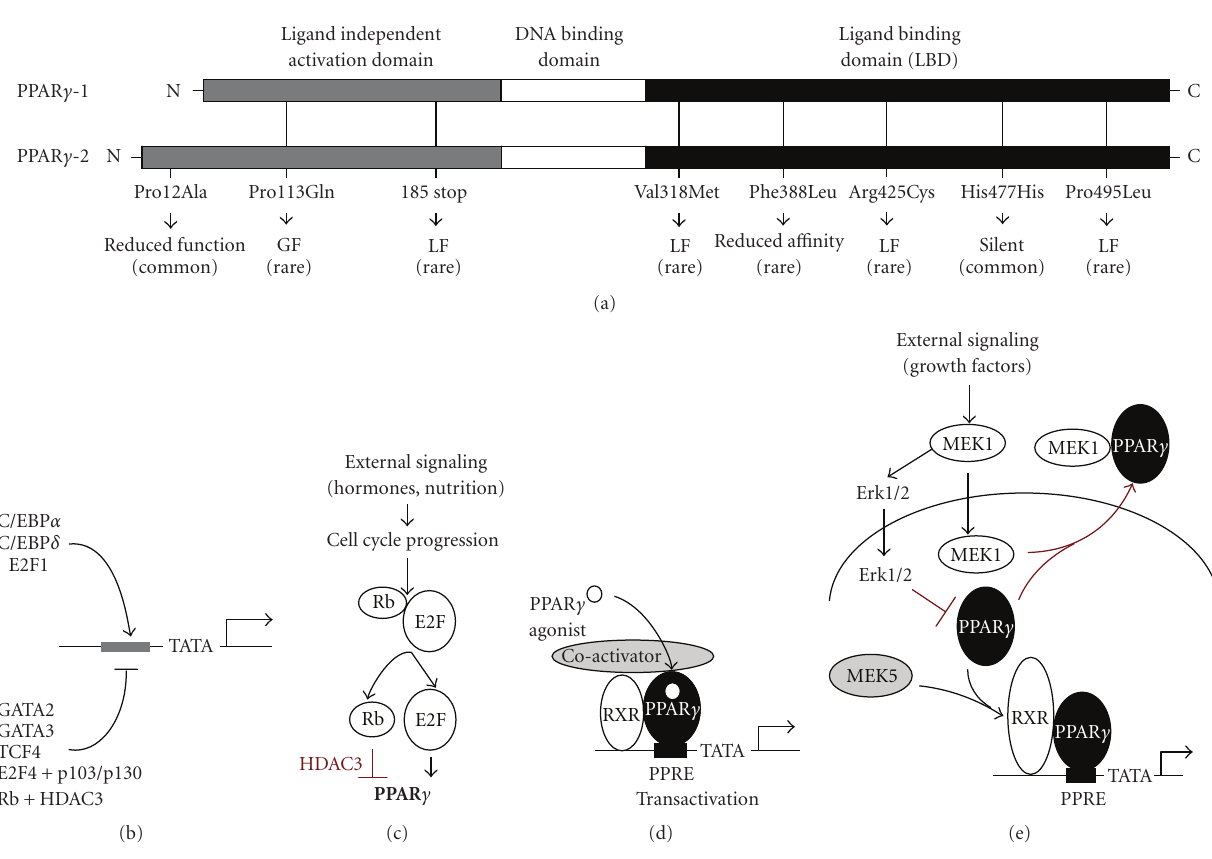
Figure 1: PPAR γ structure and regulation. (a) Schematic representation of the domain structure of the PPAR γ -1 and PPAR γ -2. The mutations associated with metabolic syndrome are indicated. LF: loss of function; GF: gain of function. (b) Positive and negative regulators of the PPAR γ gene transcription. (c) The regulation of PPAR γ levels by Rb and E2F. (d) The mechanism of ligand-dependent PPAR γ activation. (e) The regulation of PPAR γ activity by MEK and Erk kinases: MEK1 activates Erk-1/2, which phosphorylates PPAR γ and targets it to proteasomes; in addition, MEK1 binds PPAR γ in the nucleus and exports it to the cytoplasm. MEK5 can serve as coactivator for the PPAR γ